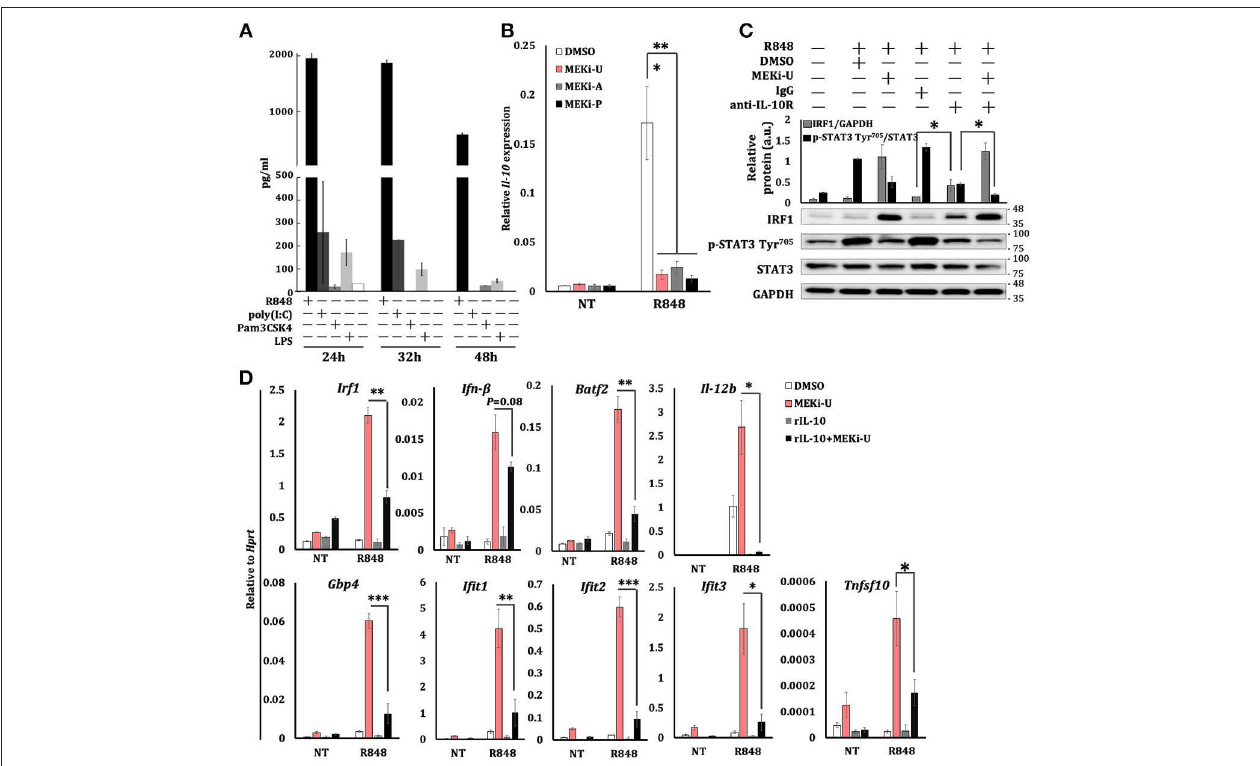
FIGURE 5 | MEK1/2 pathway constrains IRF1-mediated interferon signature response through the IL-10 signaling. (A) ELISA analysis of IL-10 secretion from BMDM stimulated as indicated. Data are means ± SD pooled from 3 experiments. (B) qRT-PCR analysis of Il-10 mRNA expression in BMDM stimulated with R848 for 6h in the presence or absence of three MEK1/2 inhibitors. Data are means ± SD pooled from 4 experiments. (C) Immunoblot analysis and quantitative densitometry of IRF1, total, and p-STAT3 abundance in lysates of BMDM treated with R848 for 8h in the presence or absence of MEKi-U, anti-IL-10R antibody, and IgG isotype control. Blots are representative of 4 independent experiments. Molecular weight (kDa) markers are indicated on the right side of the blots. Quantified data are means ± SD from all experiments. (D) qRT-PCR analysis of mRNA expression of the indicated genes in BMDM cells stimulated with R848 and recombinant IL-10 (20ng/ml) for 6h in the presence or absence of MEKi-U. Data are means ± SD pooled from 4 experiments. * P < 0.05, ** P < 0.01, and *** P < 0.001 by one-way ANOVA (B) or unpaired Welch’s t -test (C,D)